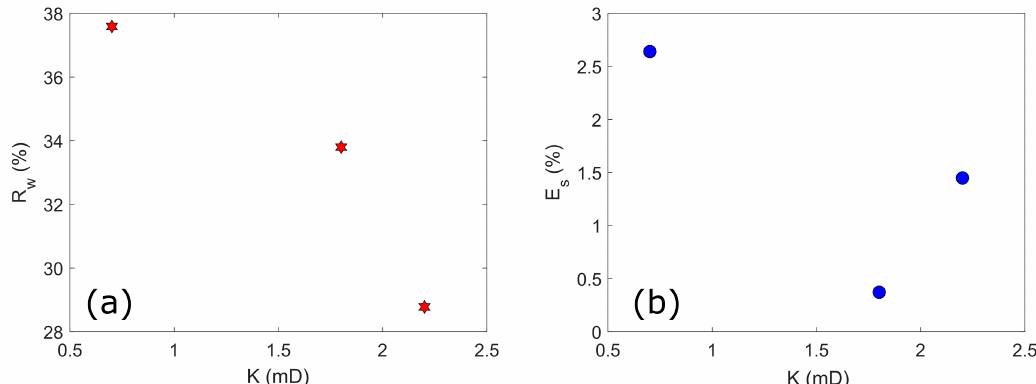
Figure 5. ( a ) Water flooding ( R w , %) and ( b ) surfactant flooding ( E s , %) against permeability of core samples K (mD).